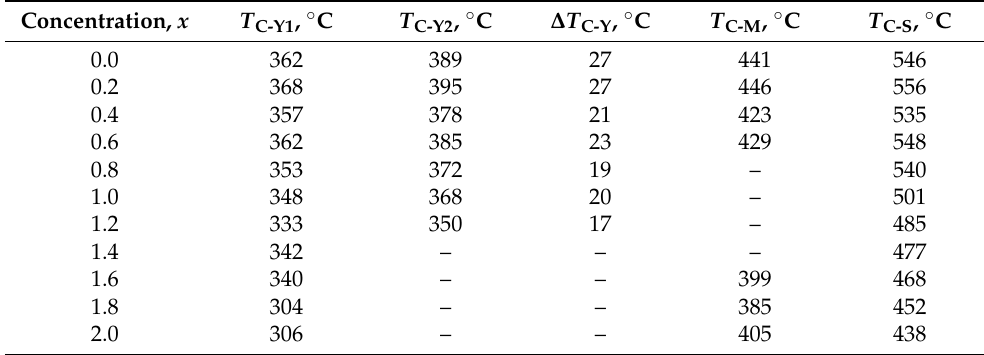
Table 2. Phase transition temperatures of the hexaferrites Ni 2-x Cu x –Y system determined from the derivatives d ( µ 0 ( T ))/ dT